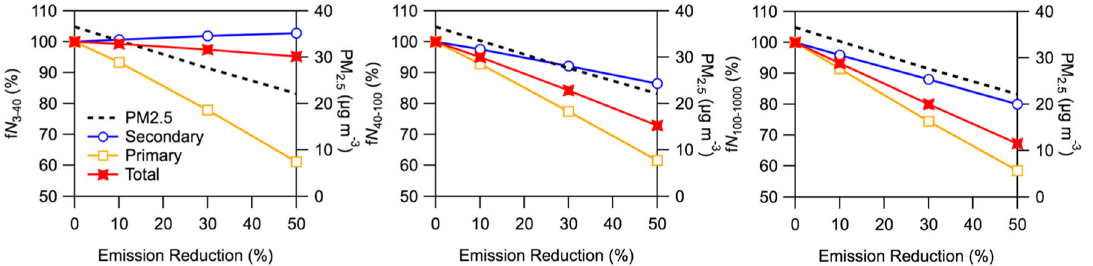
Fig. 6 The changes in particle number concentrations and PM 2.5 resulting from emission reductions in the Urban Beijing in September, 2015. The percentage change in particle number concentration (f N ) is the ratio between particle number concentration after and in the absence of emission reductions. In the three sensitivity scenarios, emissions of all species including the gaseous precursors and primary particles over Beijing – Tianjin – Hebei areas were cut by 10%, 30%, and 50%, respectively. The particles are categorized into primary which are associated with direct emissions, and secondary which are associated with new particle formation.